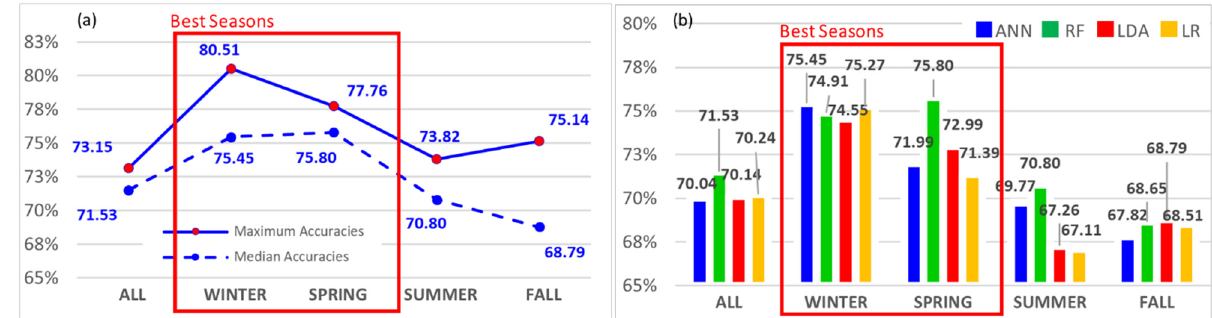
Figure 6. ( a ) Maximum accuracies and median accuracies for all seasons and per season. ( b ) Comparison among median accuracies achieved by all tested ML algorithms.